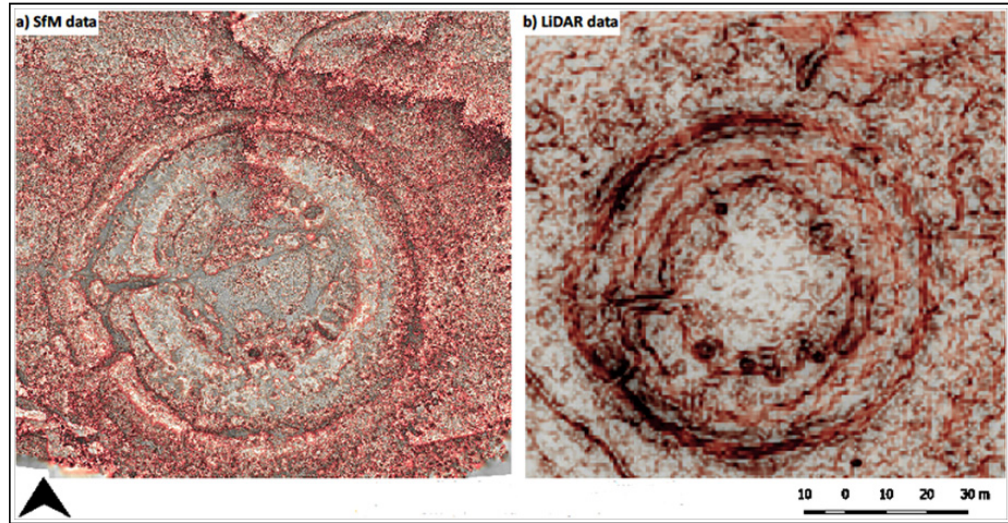
Figure 5. RRIM raster images highlight the archaeological features of the Chun Castle applying: ( a ) SfM photogrammetry; ( b ) LiDAR datasets.